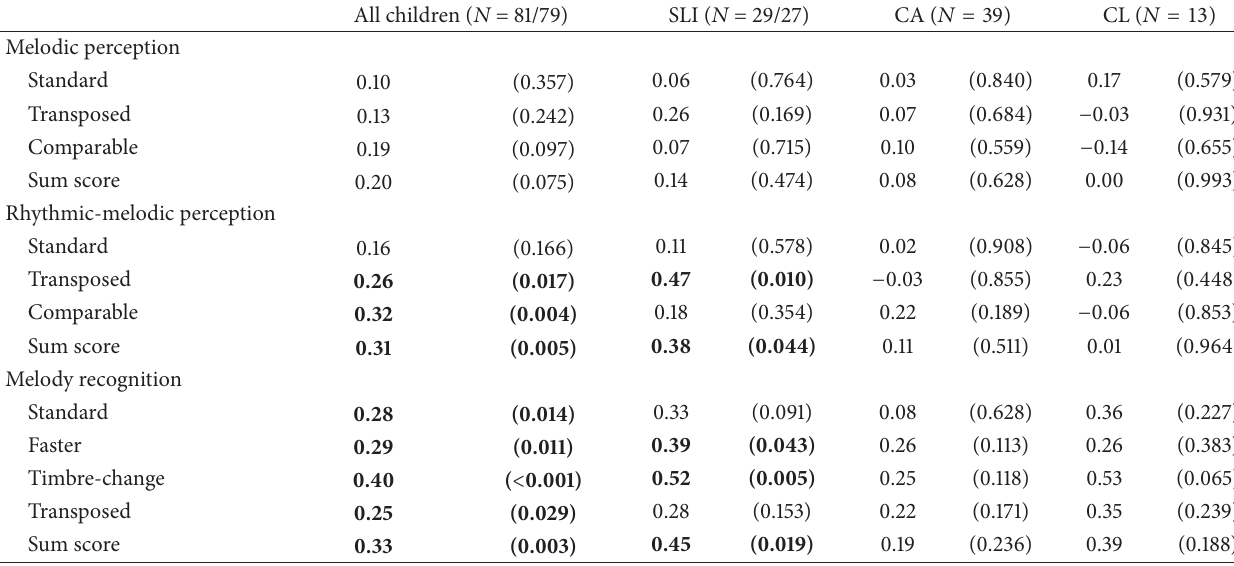
Table 3: Correlations of all music perception subtests with the language comprehension subtest of the language screening (significance level in parentheses) for all groups of children (first column) as well as each subgroup separately (second to fourth column). Significant correlations are indicated by bold typeface.